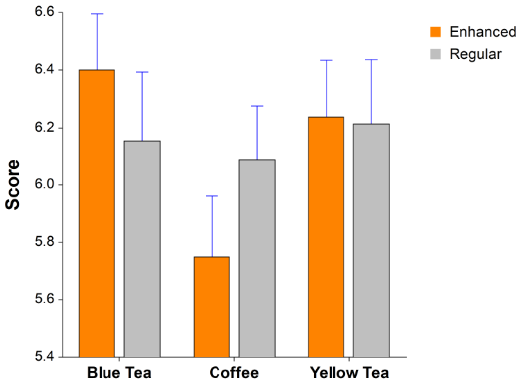
Figure 2. Comparison of beverage likeability. Whiskers represent the standard error of the mean (SEM).